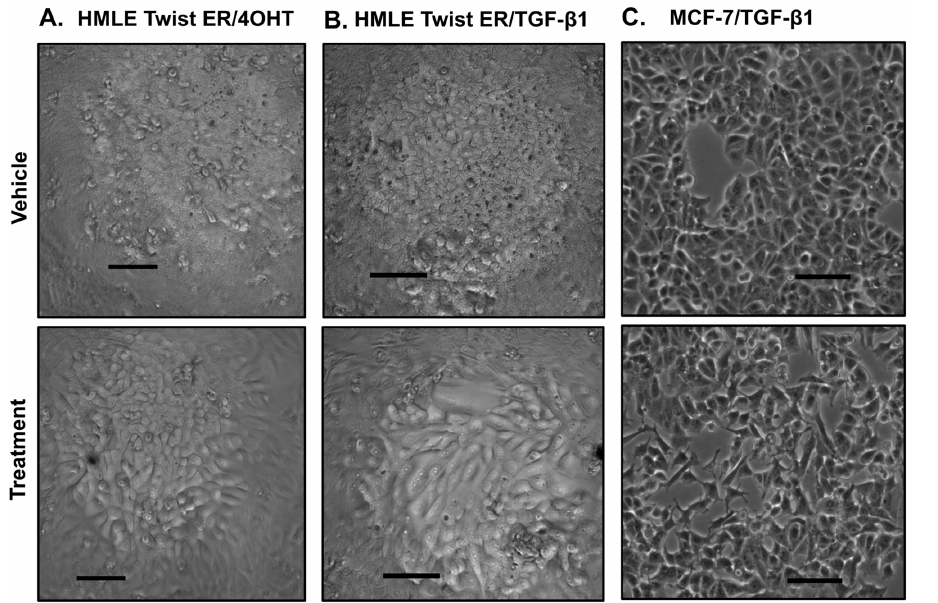
Figure 1. Representative morphology of cells under array conditions following 4 days of treatment. Top panel: vehicle control; bottom panel: cells treated with EMT inducers. HMLE Twist ER cells in 384- well plates used for arrays lost the ability to form a dense epithelial sheet, consistent with the loss of adherens junctions and other epithelial structures observed in EMT. Cells were also elongated and spindle-shaped compared to untreated controls. MCF-7 cells treated with TGF- b 1 also lost the ability to pack together in the cobblestone-like formations typical of this cell line. Treated cells also lost their uniform hexagonal shape and became elongated with pleiomorphic cellular processes. A. HMLE Twist ER cells treated with vehicle or 4OHT. B. HMLE Twist ER cells treated with vehicle or TGF- b 1. C. MCF-7 cells treated with vehicle or TFG- b 1. Scale bar, 100 m m.